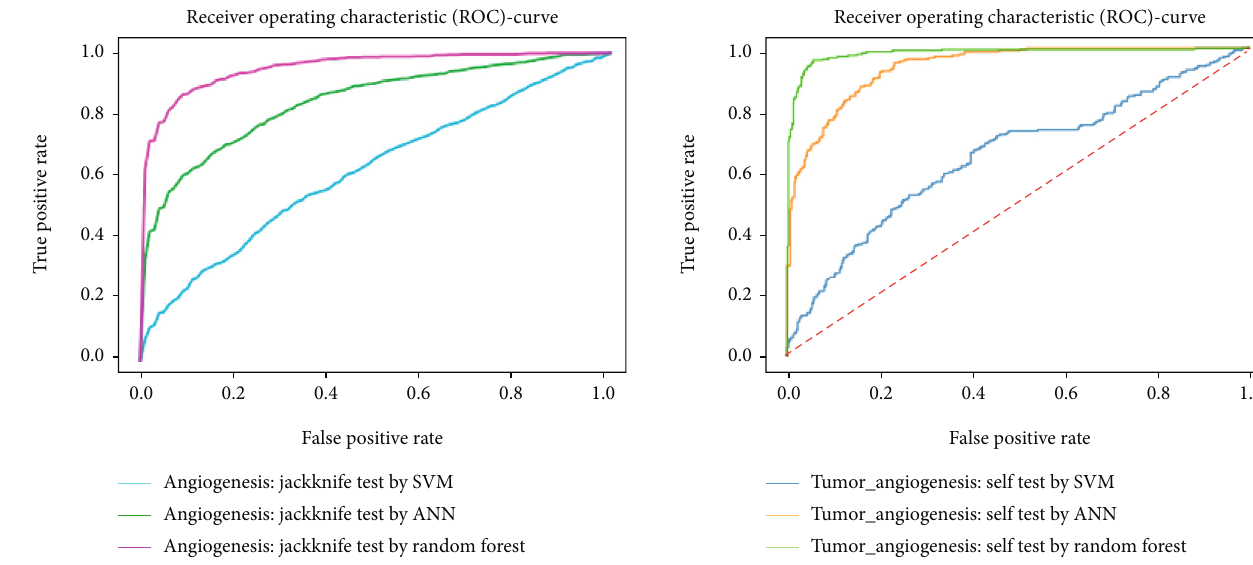
Figure 11: Comparison based on